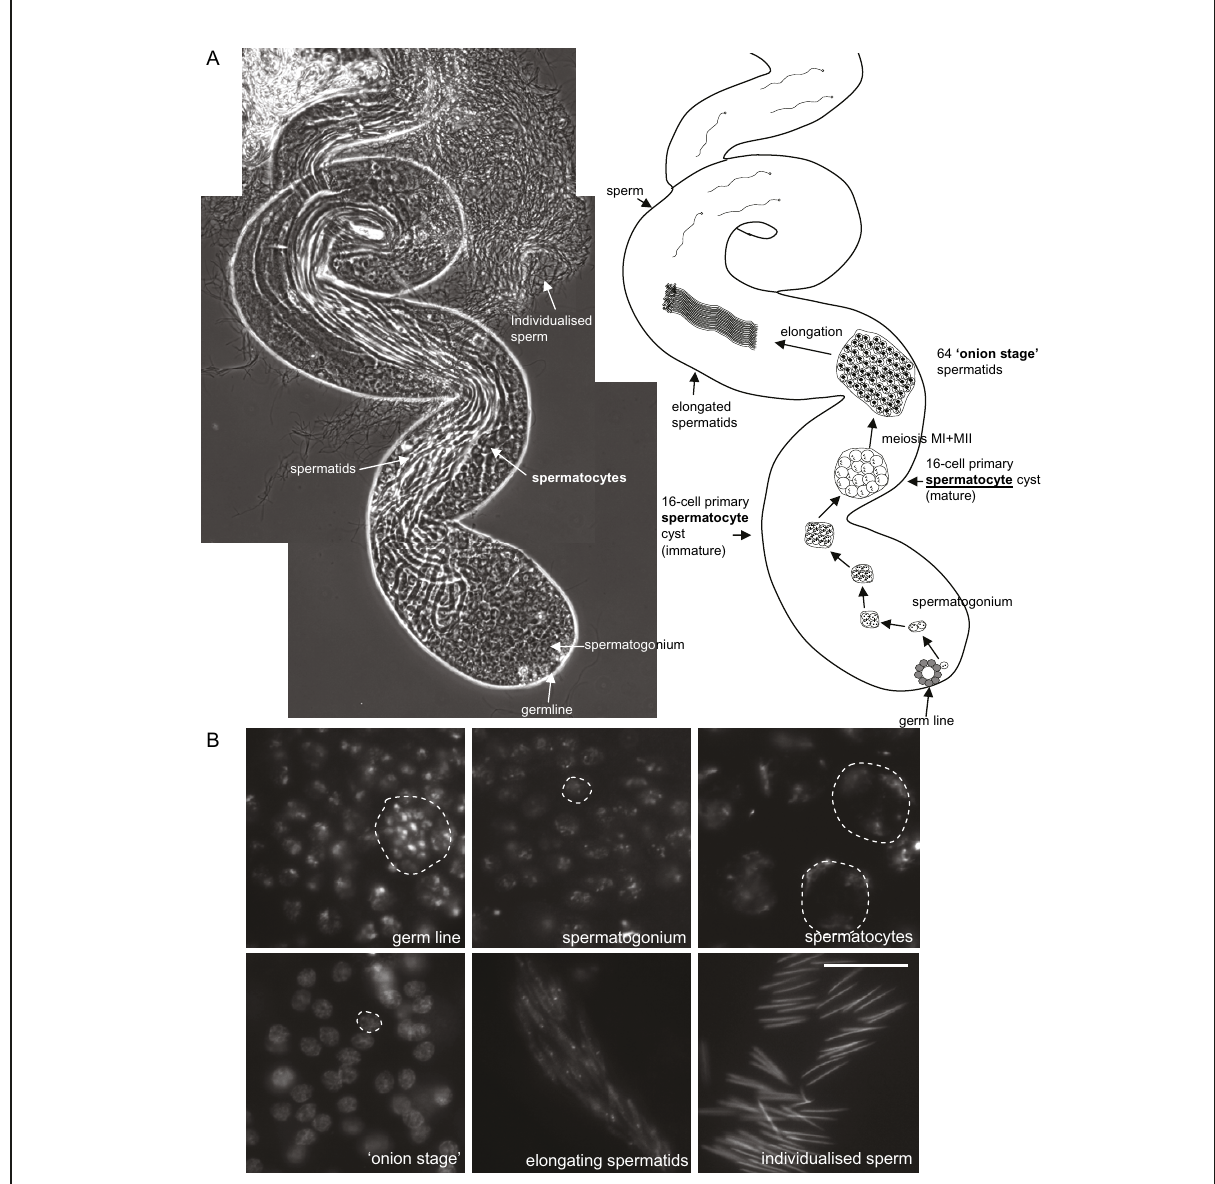
Figure 2 Basic overview of Drosophila spermatogenesis . (A) Testes were dissected from male flies and visualised by phase contrast microscopy. The overview of spermatogenesis in Drosophila is remarkably similar to that in mammals [29]. The process of spermatogenesis begins at the apical tip of the testes with a small number of self-renewing stem cells (germ line) that continually divide to maintain the stem cell number. These cells go through 4 synchronous mitotic amplifications with incomplete cytokinesis which result in a cyst of 16 interconnected spermatogonia. These spermatogonia (or primary spermatocytes) go through cellular growth, differentiation and is particularly characterised by high levels of gene expression. All 16 spermatocytes exit the cell growth program and undergo meiosis I and II to form a cyst of 64 inter-connected primary spermatids which have a single phase-light nucleus and a single phase-dark mitochondrial derivative (Nebenkern). In cross-section the Nebenkern has concentric rings of mitochondrial membranes that resemble an onion and give this stage its name ( ’ onion stage ’ ). These inter-connected haploid spermatids undergo cellular remodelling, elongating as the sperm axonemes are formed inside to form long spermatids that stretch almost the entire length of the testis. During this elongation step the spermatid flagella extend down the lumen towards the apical tip and the nuclei move down towards the basal end. The final step in spermatogenesis is a highly complex process of membrane remodelling called individualisation. In this process an actin cone assembles around the spermatid nuclei and moves synchronously from the heads to the tips of the tail, enclosing cytosol and vesicles in a cystic bulge. It is within this cystic bulge that membrane remodelling occurs to enclose each sperm axoneme to yield 64 individual sperm that are then transferred to the seminal vesicle. (B) Distinct stages in spermatogenesis can be easily visualised by Hoechst DNA staining. Bar, 20 μ